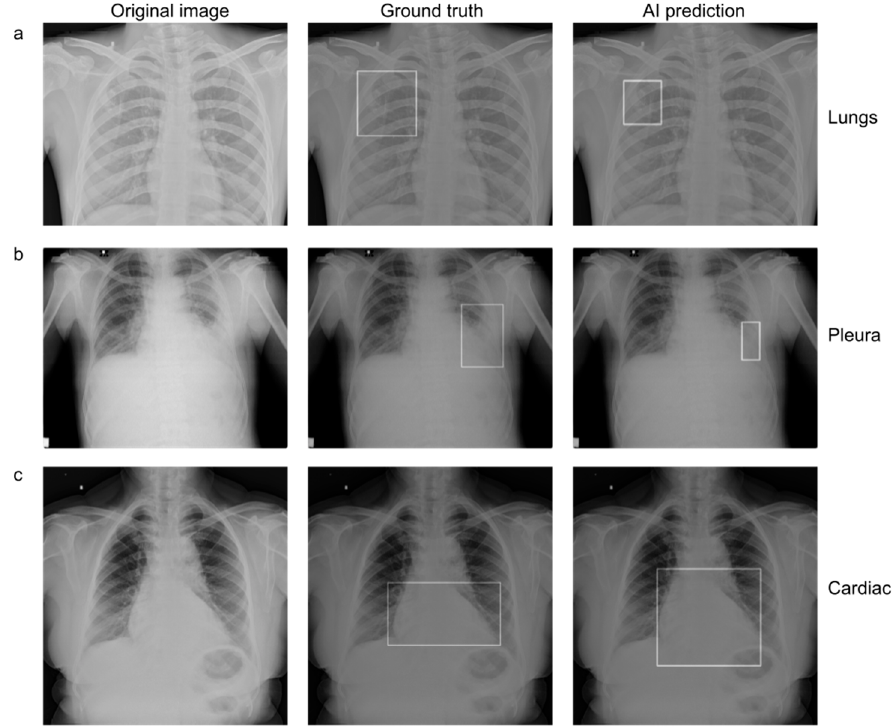
Figure 6. Examples of chest radiographs with suspicious ROIs in the ( a ) lungs, ( b ) pleura, and ( c ) cardiac categories. All three test readers missed these suspicious ROIs in the unaided session. The AI model and ground truth readers, however, predicted the suspicious ROIs as shown with bounding boxes. All three test readers identified suspicious ROIs in each category correctly when aided by AI.